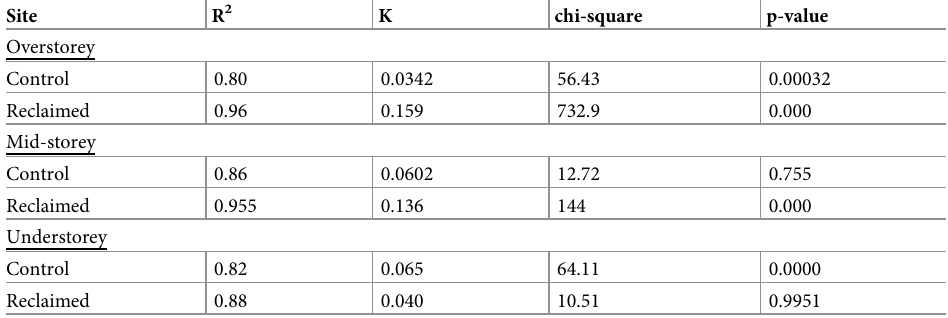
Table 4. Summary of chi-square statistics for the geometric series model applied on the reclaimed and natural forest (control) sites. Site R 2 K